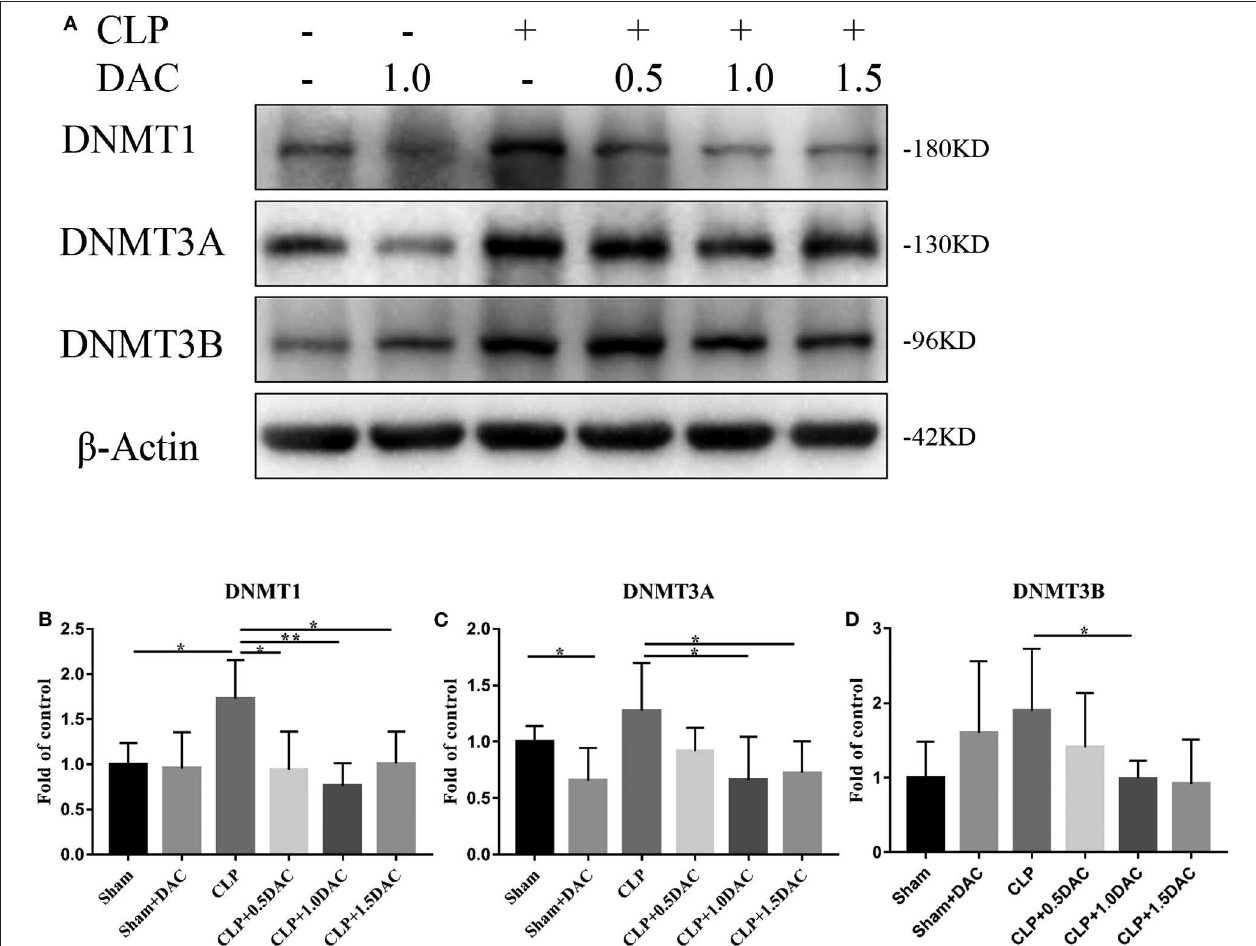
FIGURE 3 | Decitabine degrade intracellular DNMT protein level in CLP mice. (A) Representative western blot for DNMT1, DNMT3A, and DNMT3B in mice spleen with or without Decitabine treatment. (B–D) The bands were quantified by densitometry and normalized to the density of β -actin n = 5. Data were shown in Mean ± SD. ** p < 0.01, * p < 0.05. Comparisons between two groups were done by independent student’s t